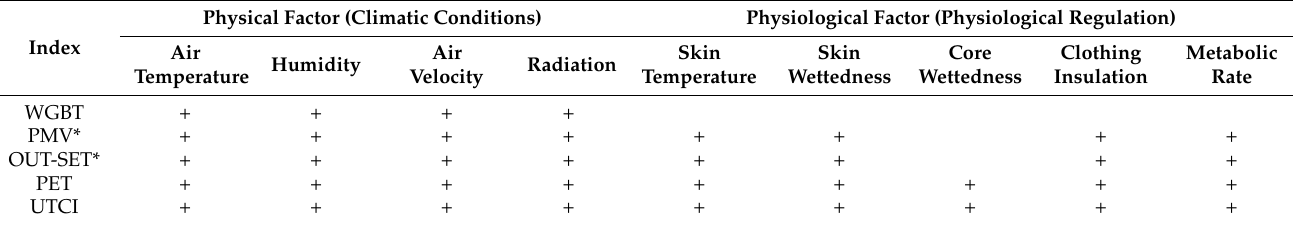
Table 2. Commonly used outdoor thermal comfort indices.